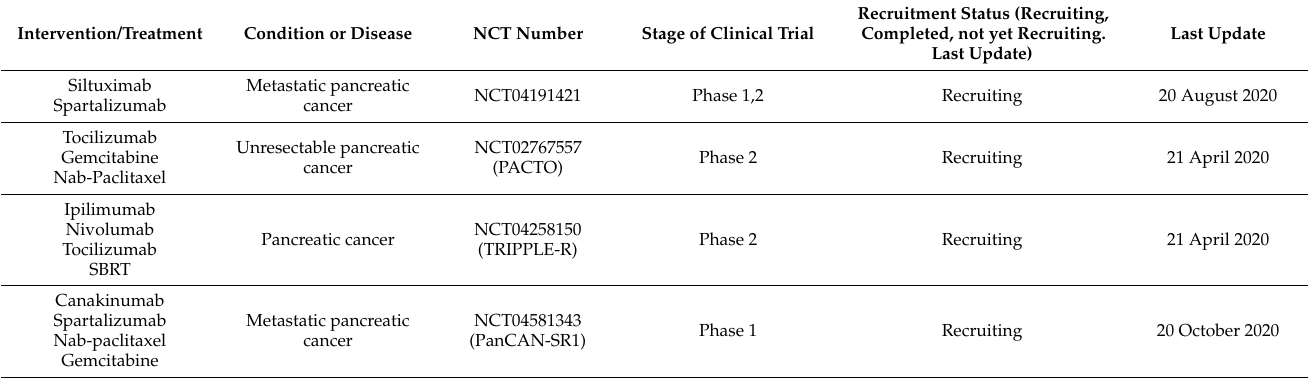
Table 2. Overview of clinical trials with targeting interaction between tumor-promoting cancer-associated fibroblasts and surrounding